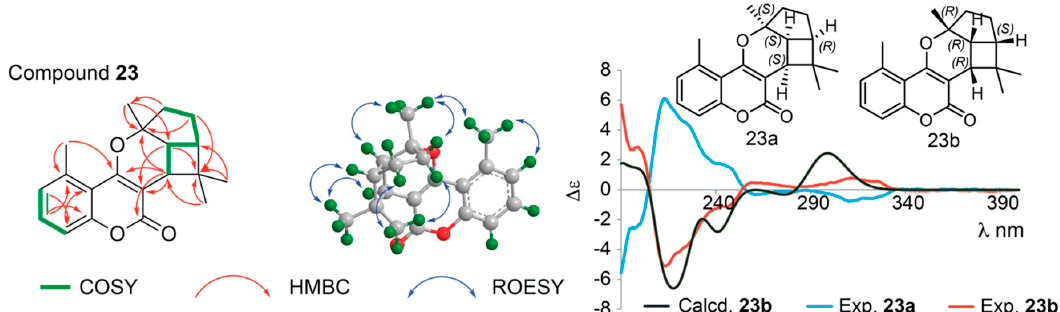
Figure 9. Left : Key COSY and HMBC correlations of 23. Middle : Key ROESY correlations to establish relative configuration of one of the enantiomers of 23 . Right : Calculated ECD spectra of 23b and experimental ECD spectra of the enantiomers 23a/b . The enantiomeric structures of 23 shown with absolute configuration of the stereocenters determined based on the ECD data.